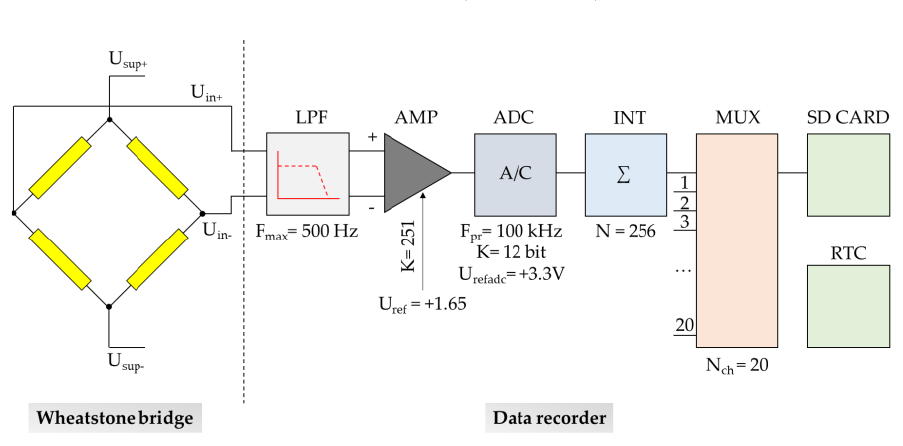
Figure 5. Block diagram of the recorder signal path.